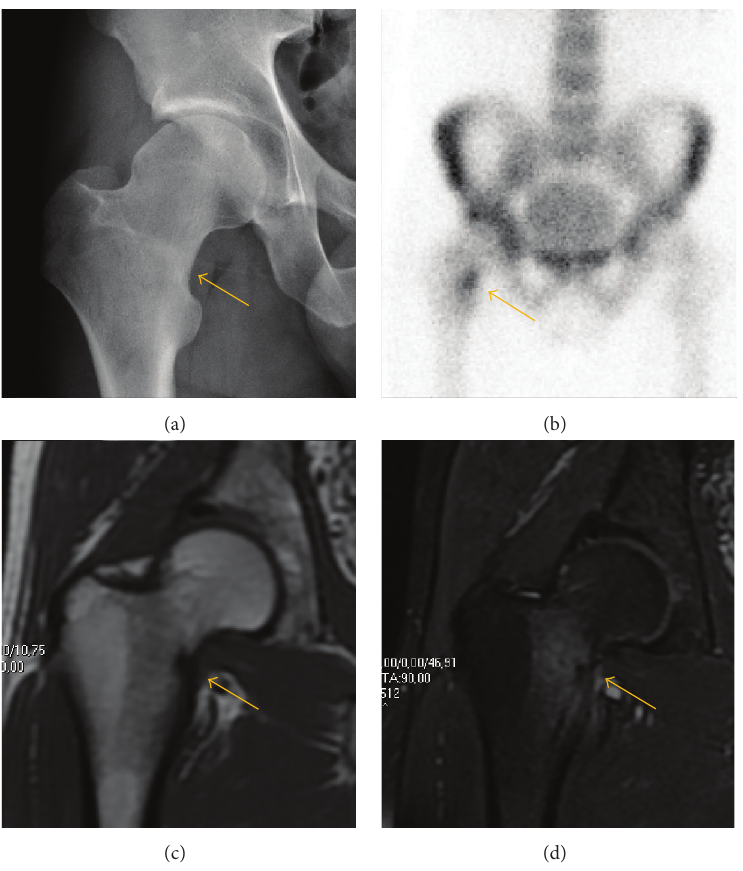
Figure 10: Stress femoral neck fracture in a young athlete barely visible in X-ray film as a sclerotic line (arrow) (a). Tc 99 scintigraphy shows a band of uptake (b), while T1 (c) and DP fat saturated (d) weighted MR images showed the fracture line and a pattern of edema.